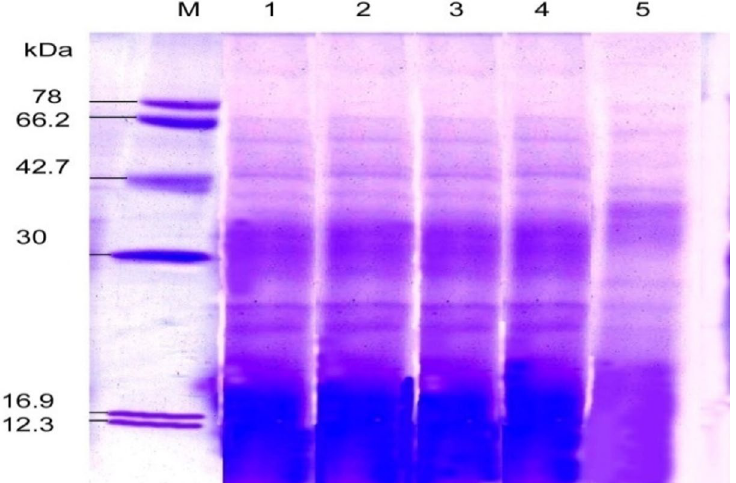
Fig. 6. SDS-PAGE of the protein profile ofsub-aerial cyanobacteria isolate: Lyngbya aerugineo-coerulea Lane 2-5 after exposure to different duration of temperature for 8 hours (35°C, 45°C, 55°C) and 3 hours (65°C), and then incubated for 15 days under continuous illumination (2000 lux) at 25±2°C. An equal amount of proteins were loaded into each well. Control (25°C), Lane 1; M. Molecular mass of standard proteins in kDa.